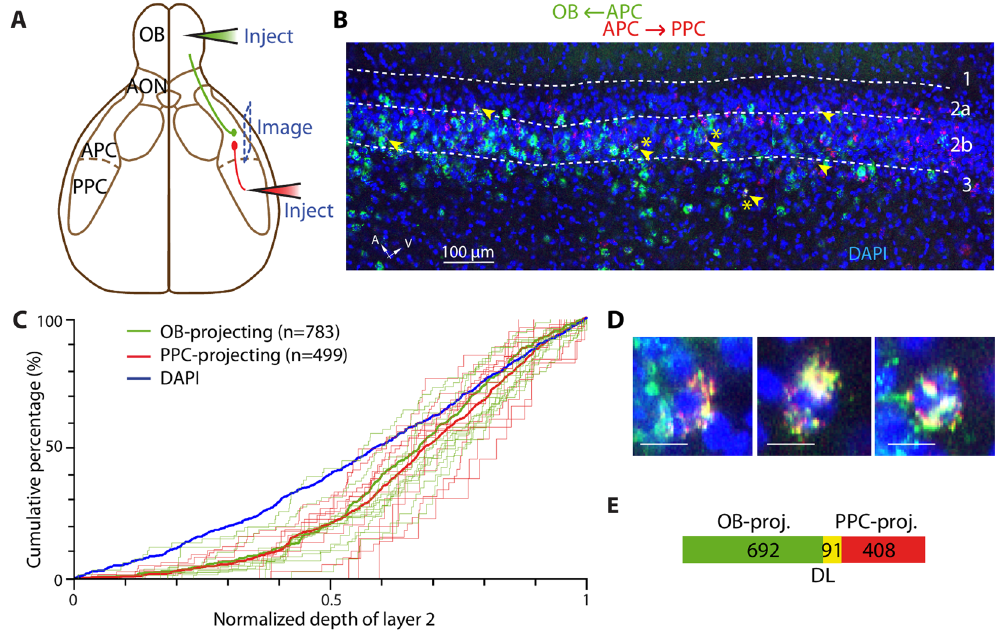
Figure 3. OB- and PPC-projecting cells are partially overlapping populations. ( A ) Schematic representation of the dual injection strategy. Green Retrobeads were injected into the OB while red Retrobeads were injected into the PPC. Images were taken from the APC. ( B ) Example APC section with OB- (green) and PPC-projecting (red) neuron population, spatially overlapping. Arrowhead: dual-labeled neurons. ( C ) OB- and PPC-projecting neurons share similar distributions within APC layer 2 (p = 0.052, n = 782 and n = 499 OB- and PPC-projecting neurons, respectively, 12 sections, 5 mice, Kolmogorov-Smirnov test). The thin green and red traces represent quantifications from single optical sections. The thick green and red traces are the distribution of all the OB- and PPC-projecting neurons respectively. ( D ) Blow-up of the starred arrows in B., showing 3 dual-labeled neurons in layer 2b. Scale bars: 10 μ m. ( E ) Venn diagram representing the counted number of dual-labeled cells (DL) in each